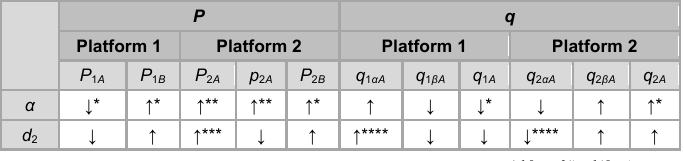
Comparative statistics cs for the scenario where γ=